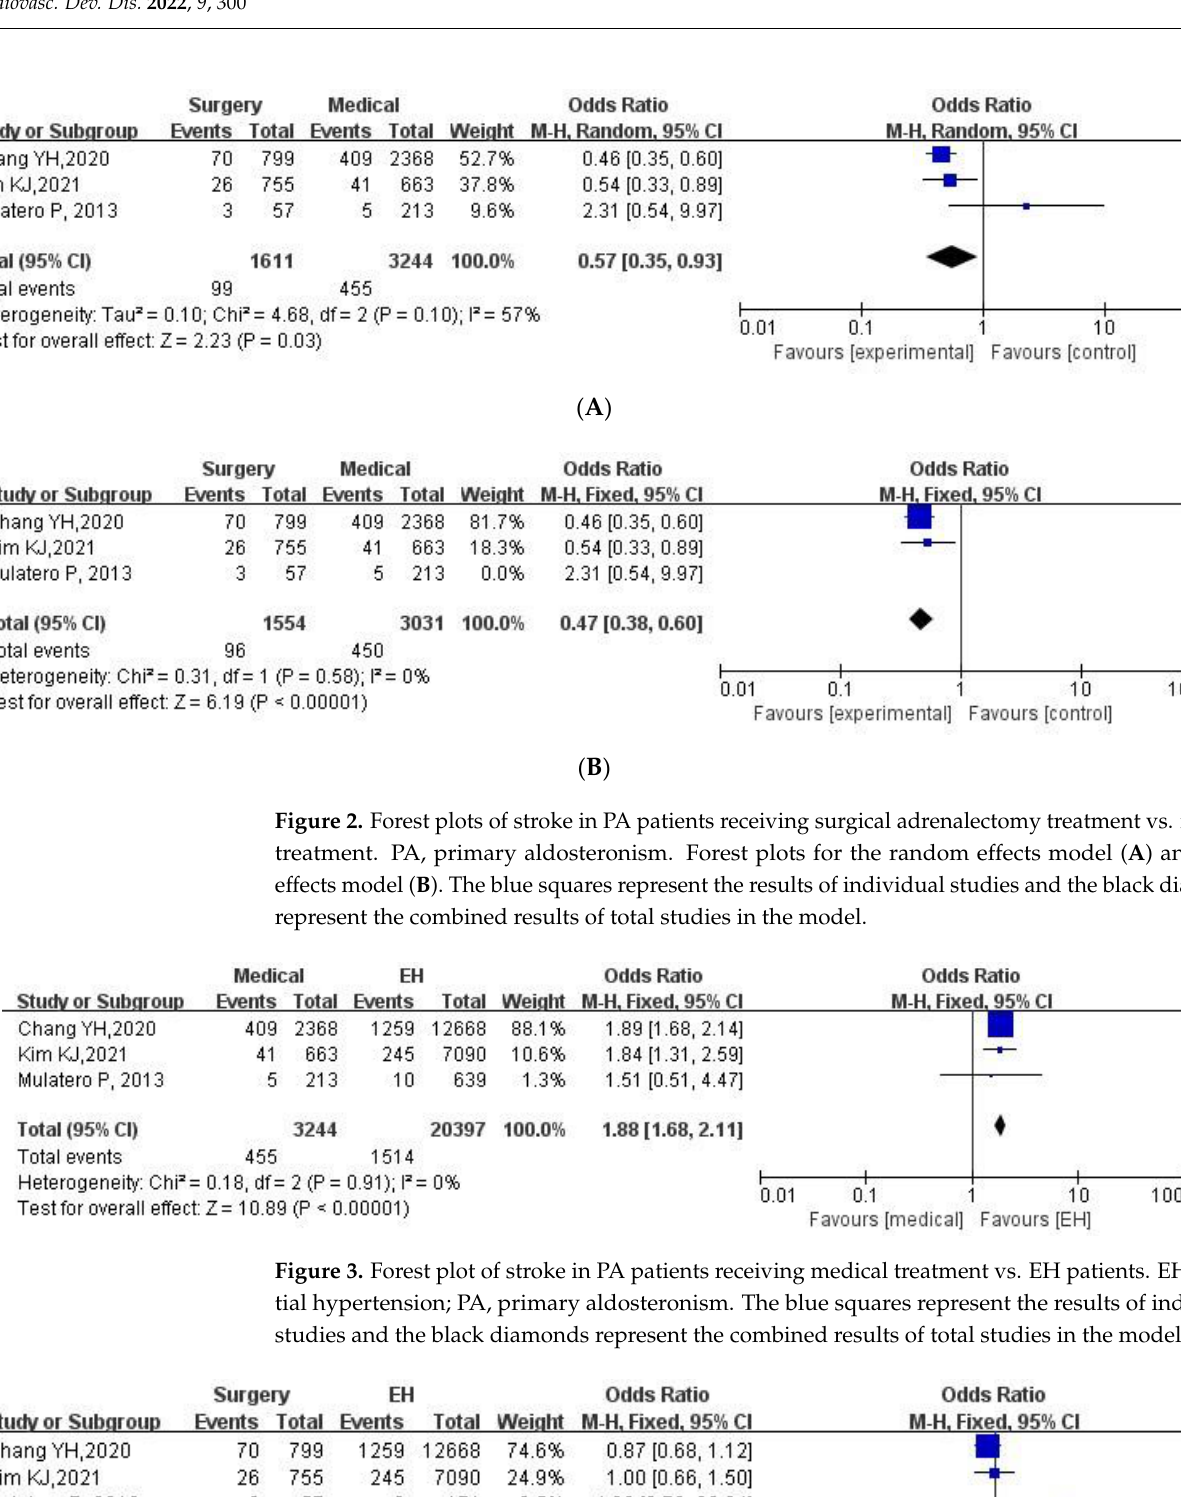
Figure 3. Forest plot of stroke in PA patients receiving medical treatment vs. EH patients. EH, es- sential hypertension; PA, primary aldosteronism. The blue squares represent the results of individ- ual studies and the black diamonds represent the combined results of total studies in the model.